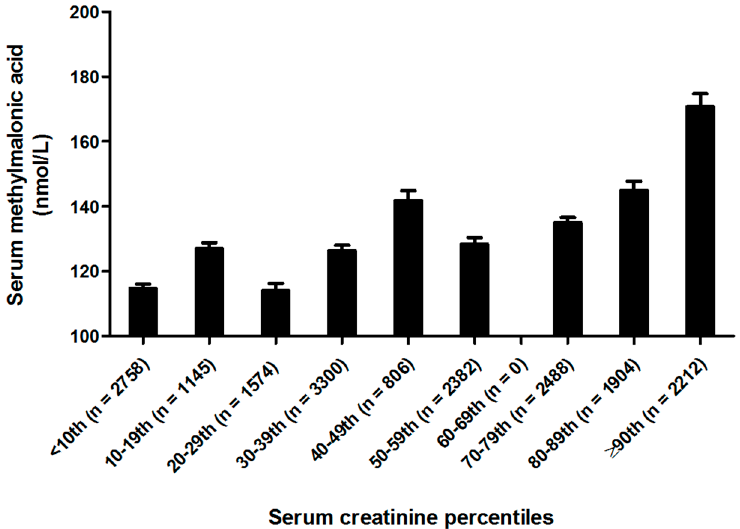
Figure 3. Serum creatinine stratified geometric mean concentrations of serum methylmalonic acid (MMA) for ≥ 12 years old persons in the US ( n = 18,569). MMA values for serum creatinine concentrations were adjusted for sex, race-ethnicity, age, supplement use and serum vitamin B-12. Analysis was performed on log MMA concentrations to satisfy normality.